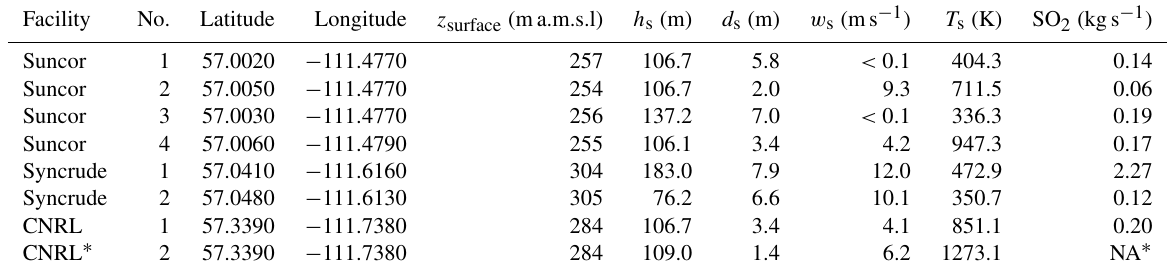
Table 1. CEMS stack parameters for all stacks within the flight area that emit significant SO 2 , including location and elevation at the stack base ( z surface ), stack height ( h s ), stack diameter ( d s ), effluent velocity at the stack exit ( w s ), and effluent temperature at the stack exit ( T s ). Velocities and temperatures shown here are averages for the entire flight period. Hourly CEMS values are used for plume rise calculations. Stack numbers (No.) are for identification within this analysis and do not represent official reporting ID. The SO 2 emission rates from 2010 inventory are shown for comparison. The listing of NA indicates CEMS SO 2 emission data are not available for this stack.